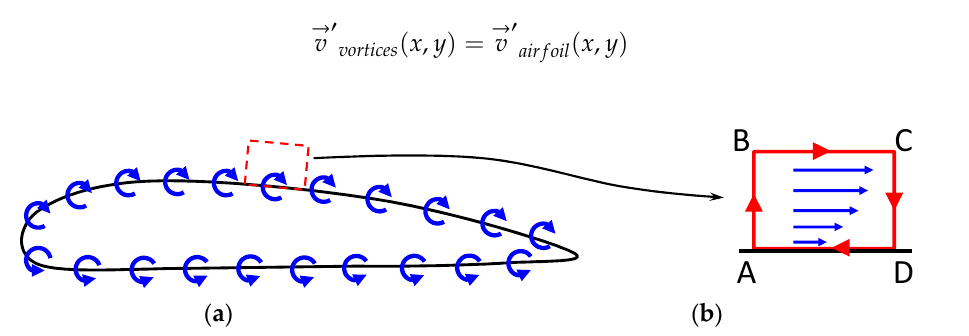
Figure 2. Illustration of the concentrated vortex of an airfoil. Another choice is to properly distribute vortices over the airfoil, as illustrated in Figure 3a. The vortex distribution needs to meet two requirements. First, the sum of the circulations of the distributed vortices should be equal to the circulation of the concentrated vortex, 1 n